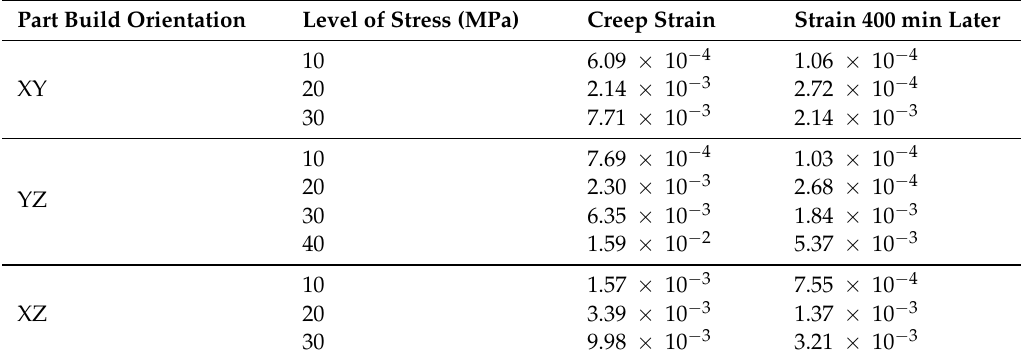
Table 6. Strain recovery values for each orientation and each stress just before and after removing the stress and 400 min later. Strain is given in